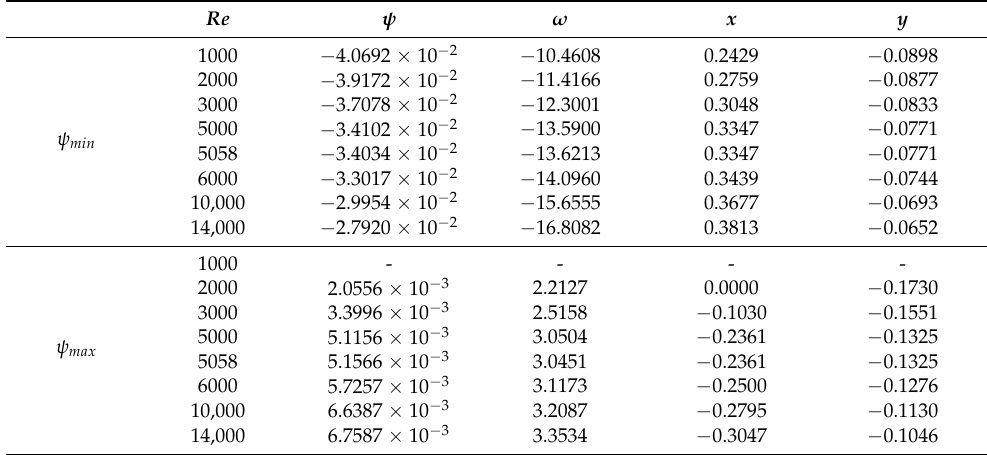
Table 3. Minimum and maximum streamfunction values in the 1st solution, corresponding vorticity values and ( x , y ) locations for D = 0.5 aspect ratio.